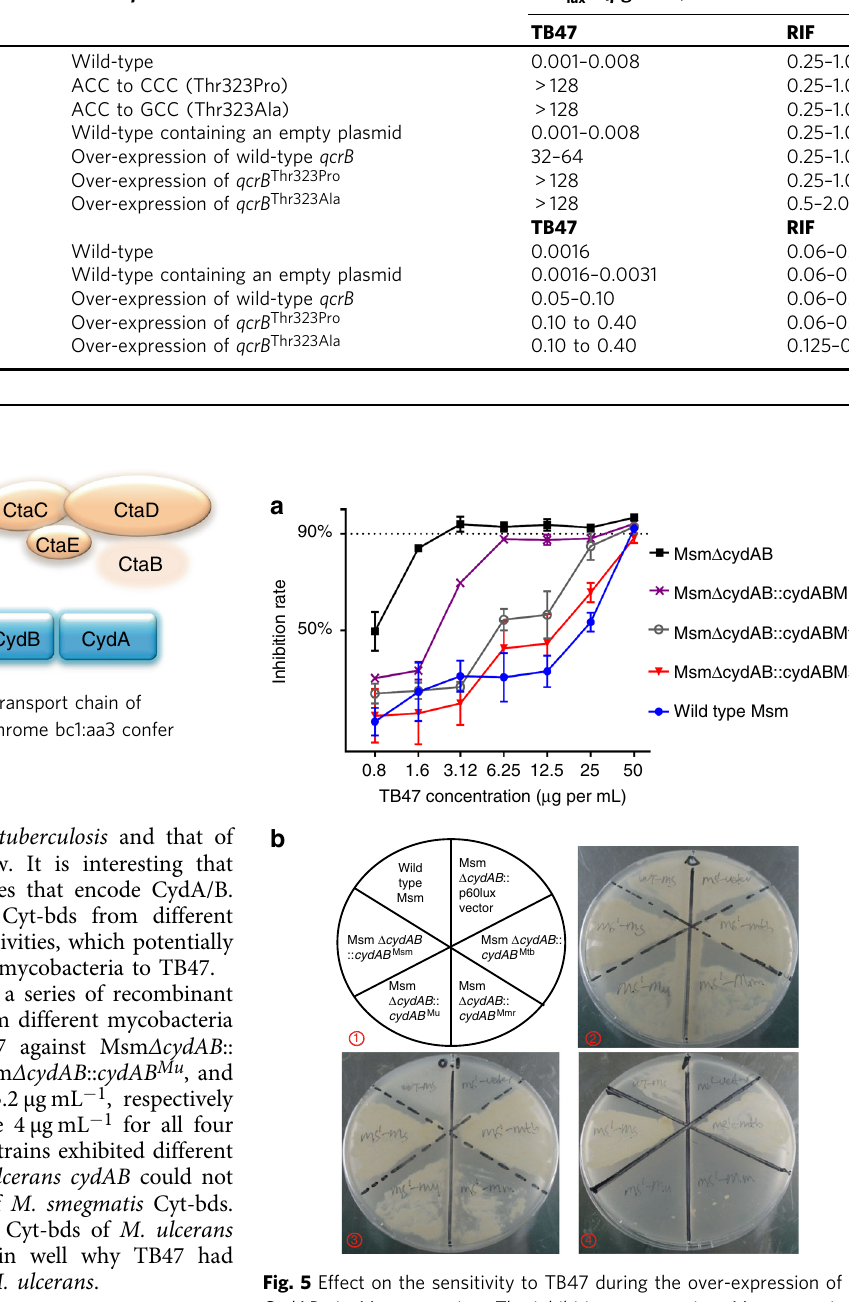
Table 1 Susceptibilities of different M. marinum / M. ulcerans strains to TB47 and rifampin in liquid using bioluminescence Mycobacteria Gene: qcrB from M. marinum